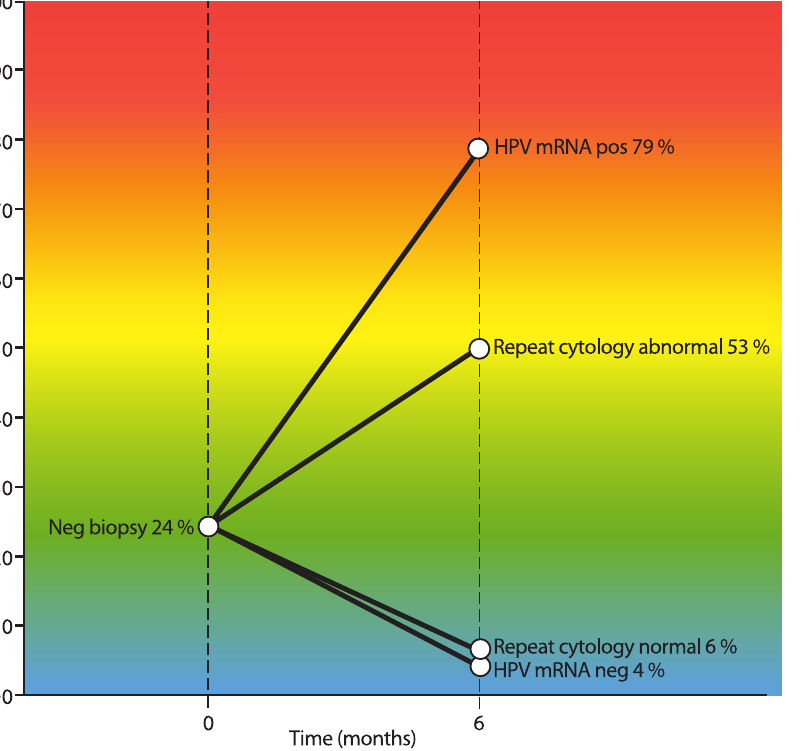
Figure 2. The detection rate of CIN2 + in follow-up of women with negative cervical biopsy by HPV mRNA positive/negative versus cytology